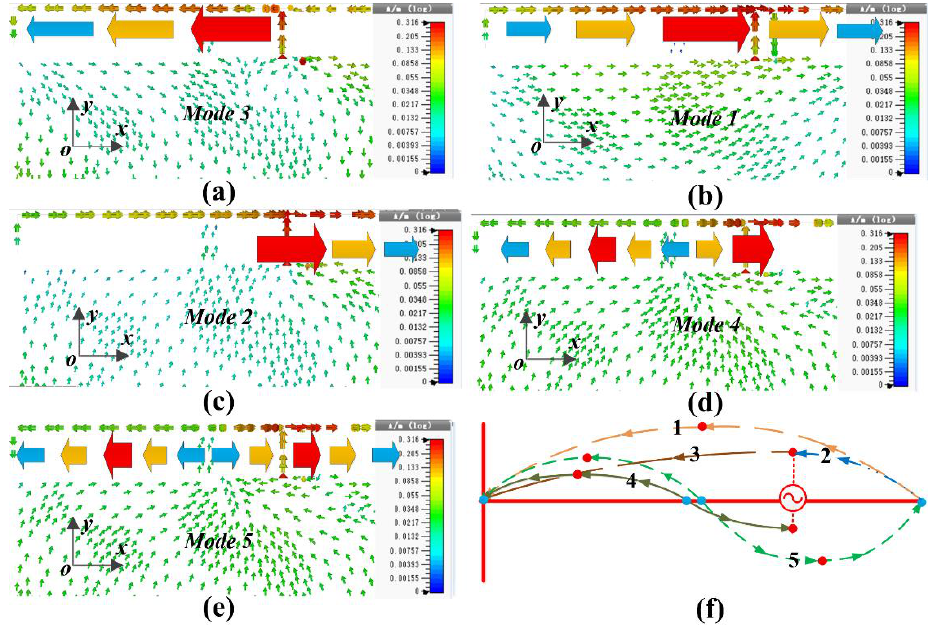
Figure 3. Surface current of the first five modes of the structure: ( a ) Mode 3; ( b ) Mode 1; ( c ) Mode 2; ( d ) Mode 4; ( e ) Mode 5; ( f ) all